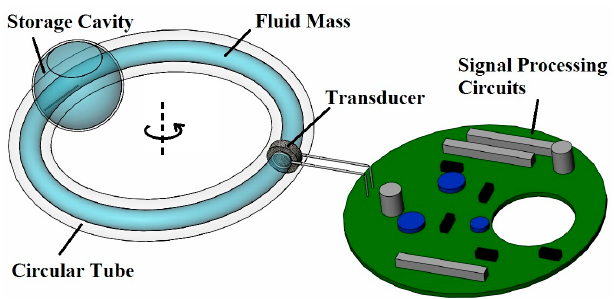
Figure 1. Structure of the liquid-circular angular accelerometer (LCAA).